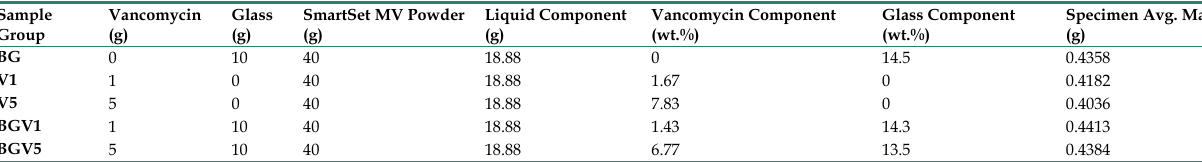
Glass SmartSet MV Powder (g) (g)